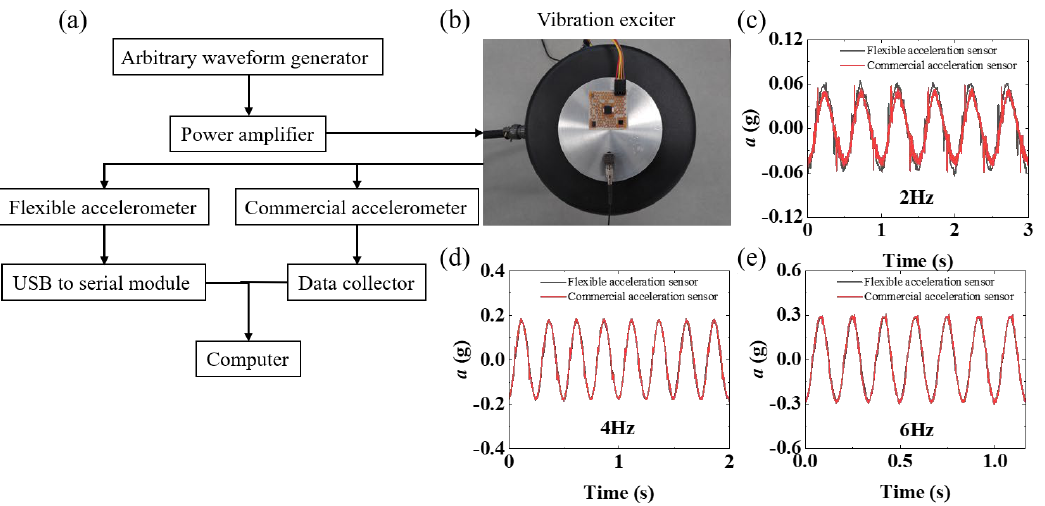
Figure 2. Three-dimensional morphology of the copper wire of the accelerometer and maximum principal strains obtained by experiments and mechanical simulations with external loading condi- tions of ( a ) bending, ( b ) stretching, ( c ) twisting.